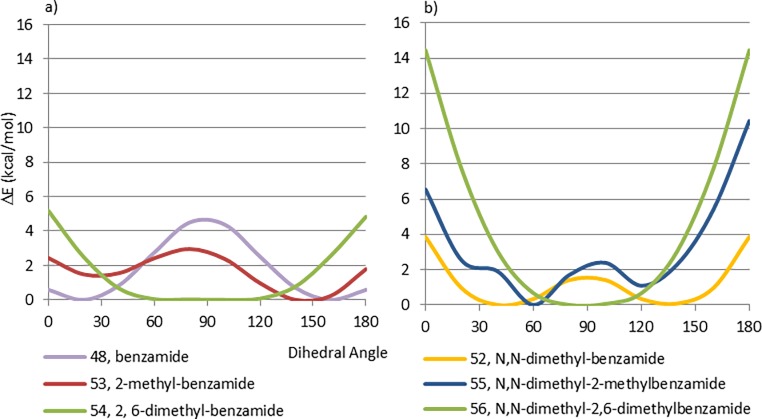
a) Effect of methyl groups in benzamide 48, b) Effect of methyl groups in dimethylated amides 52, 55 and 56.